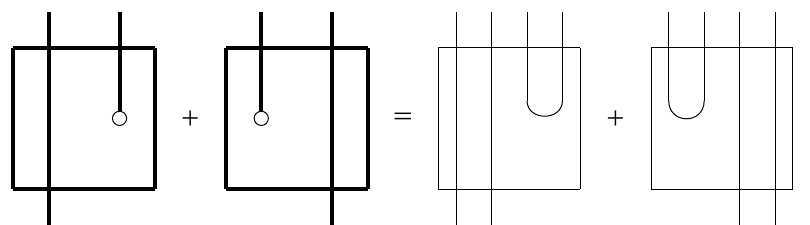
Morphism implementing addition of density matrices